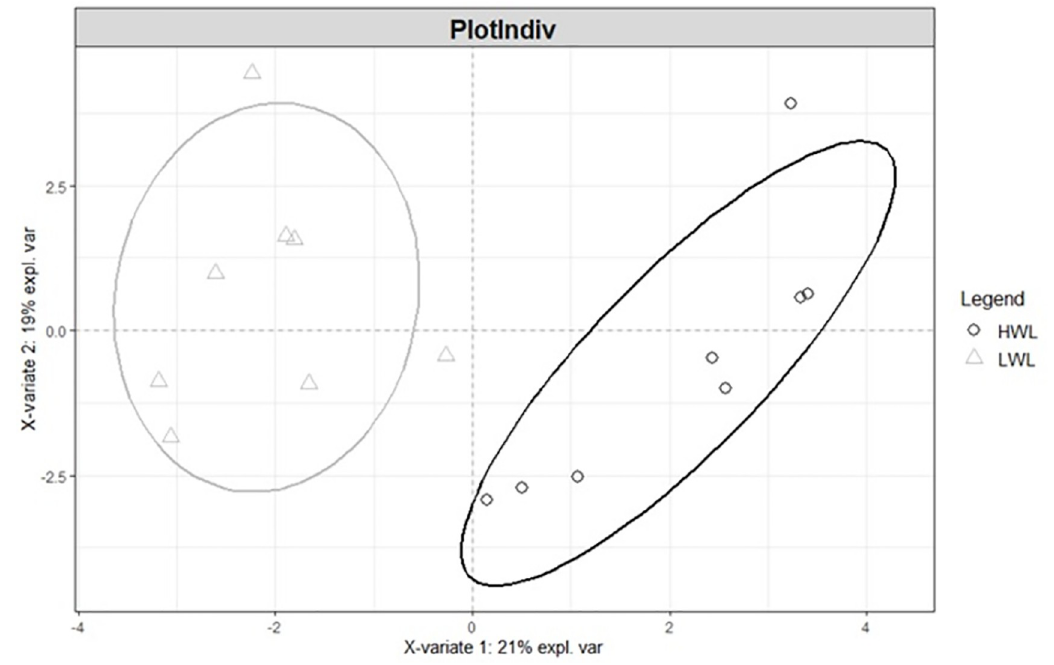
Fig 1. PLS-DA score plots according to the two first latent variables for the two liver weight groups and their 30 variant metabolites (n = 8 livers / group).